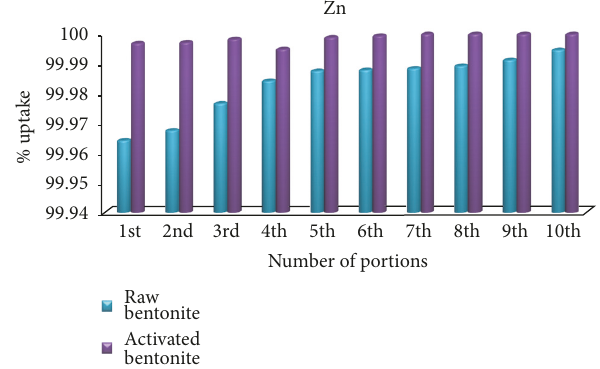
Figure 7: Percentage uptake of Zn(II) by raw and acid activated bentonite using column technique.